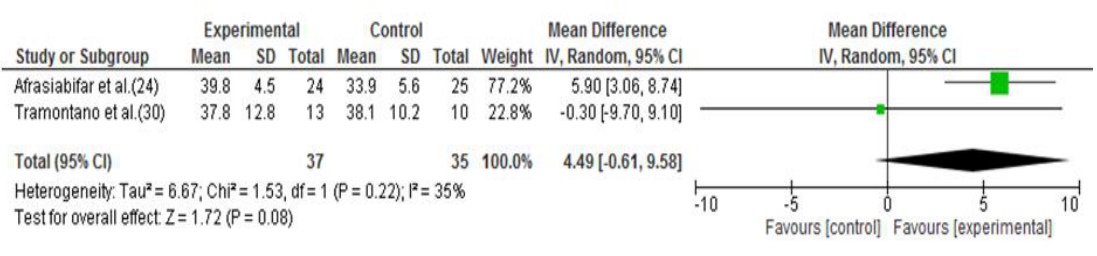
Figure 4. Forest plot of the meta-analysis of Berg Balance Scale (vestibular rehabilitation versus other exercises).